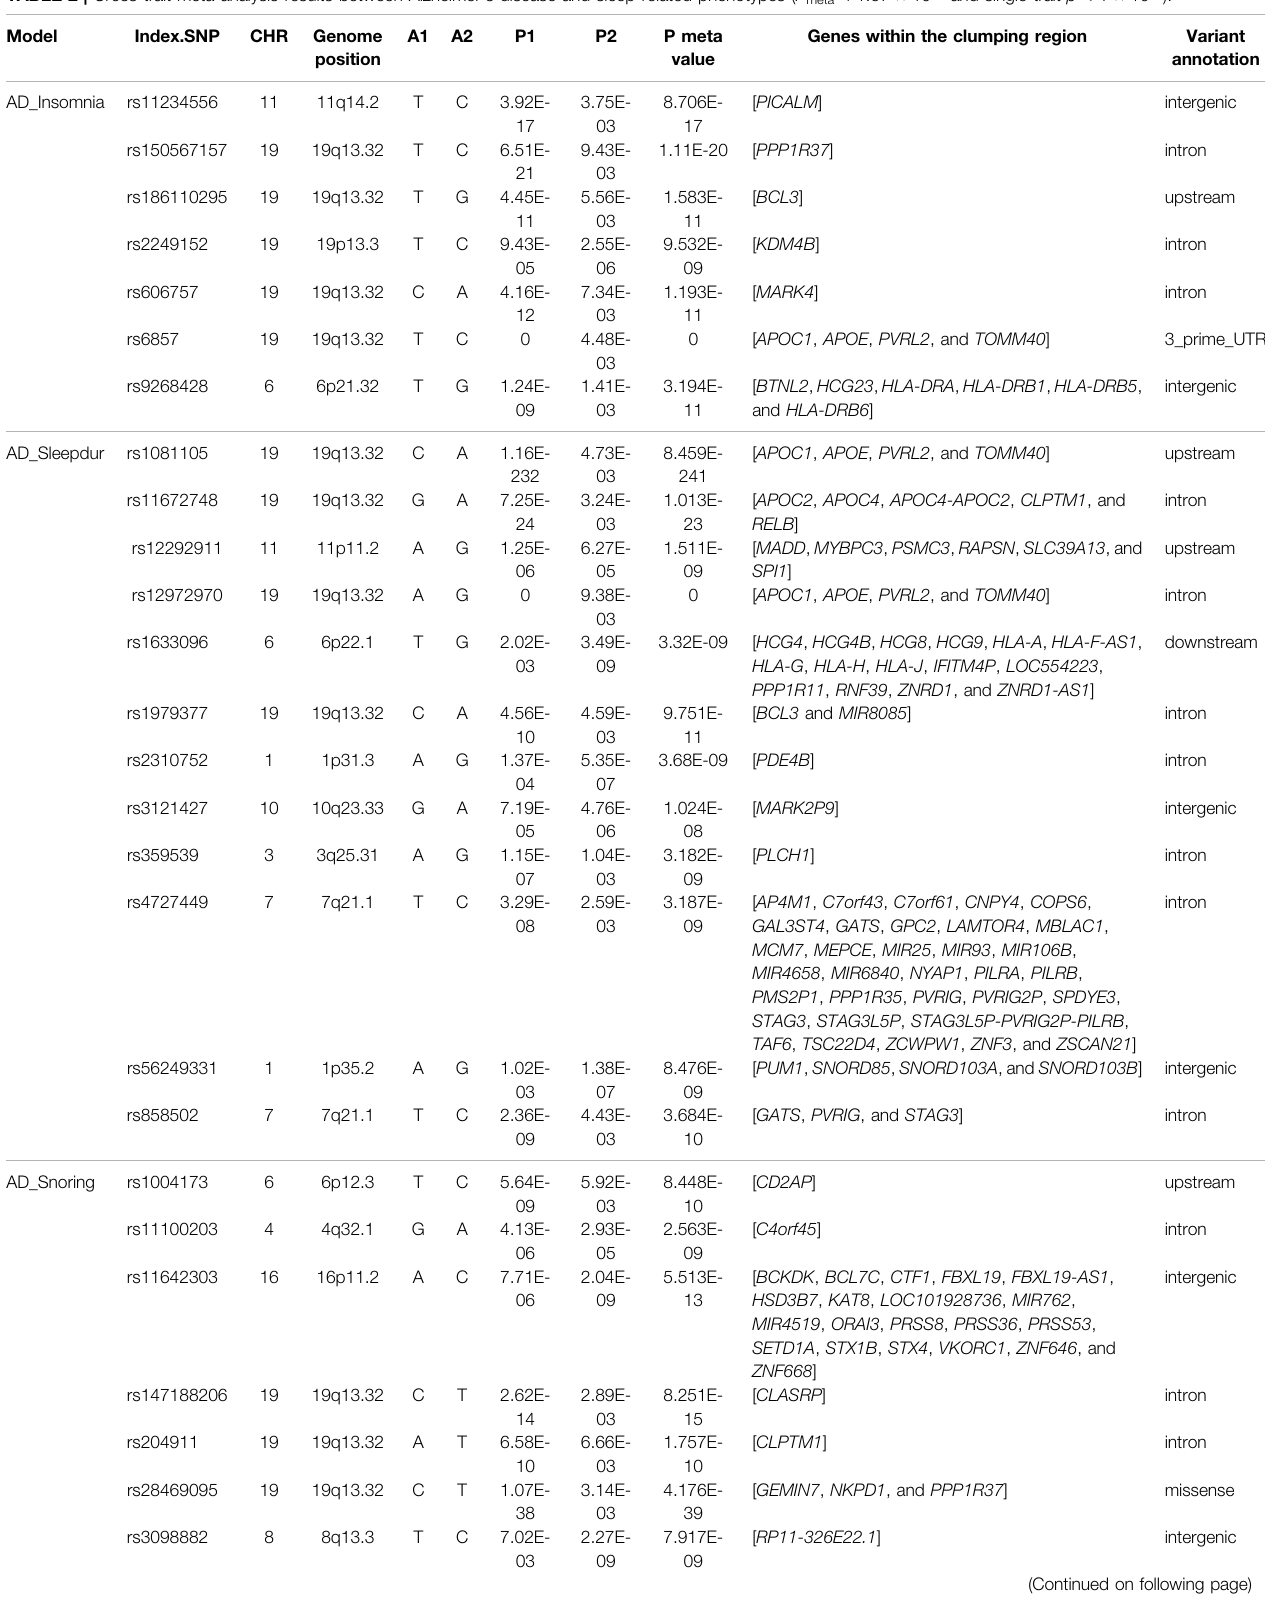
TABLE 2 | Cross-trait meta-analysis results between Alzheimer ’ s disease and sleep-related phenotypes ( P meta < 1.67 × 10 – 8 and single-trait p < 1 × 10 – 3 ).